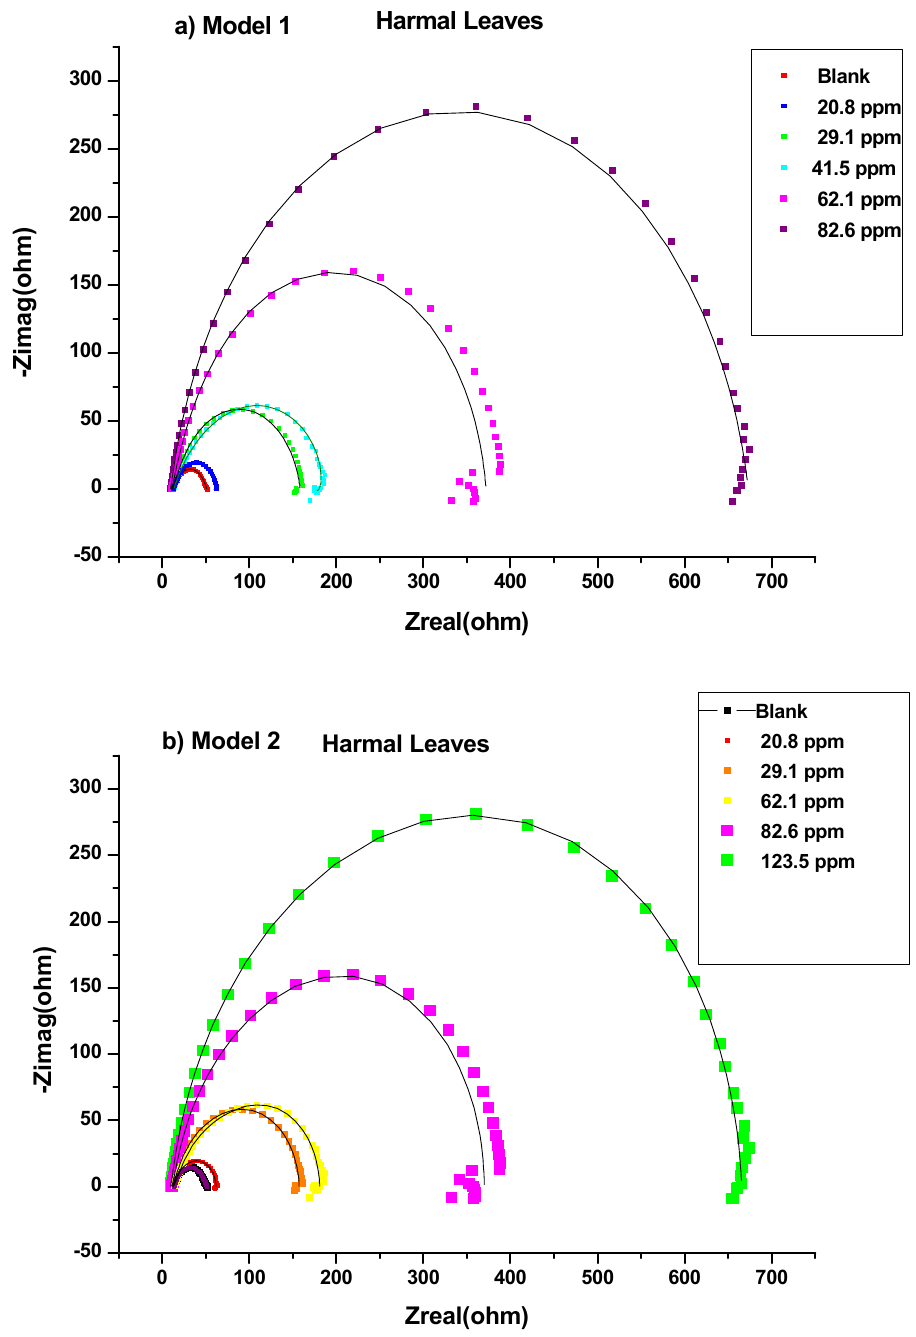
Figure 4. Nyquist plots for all concentrations of Harmal leaves extract inhibitors in 0.25 M H 2 SO 4 at 298 K fitted by ( a ) Model 1 and ( b ) Model 2.